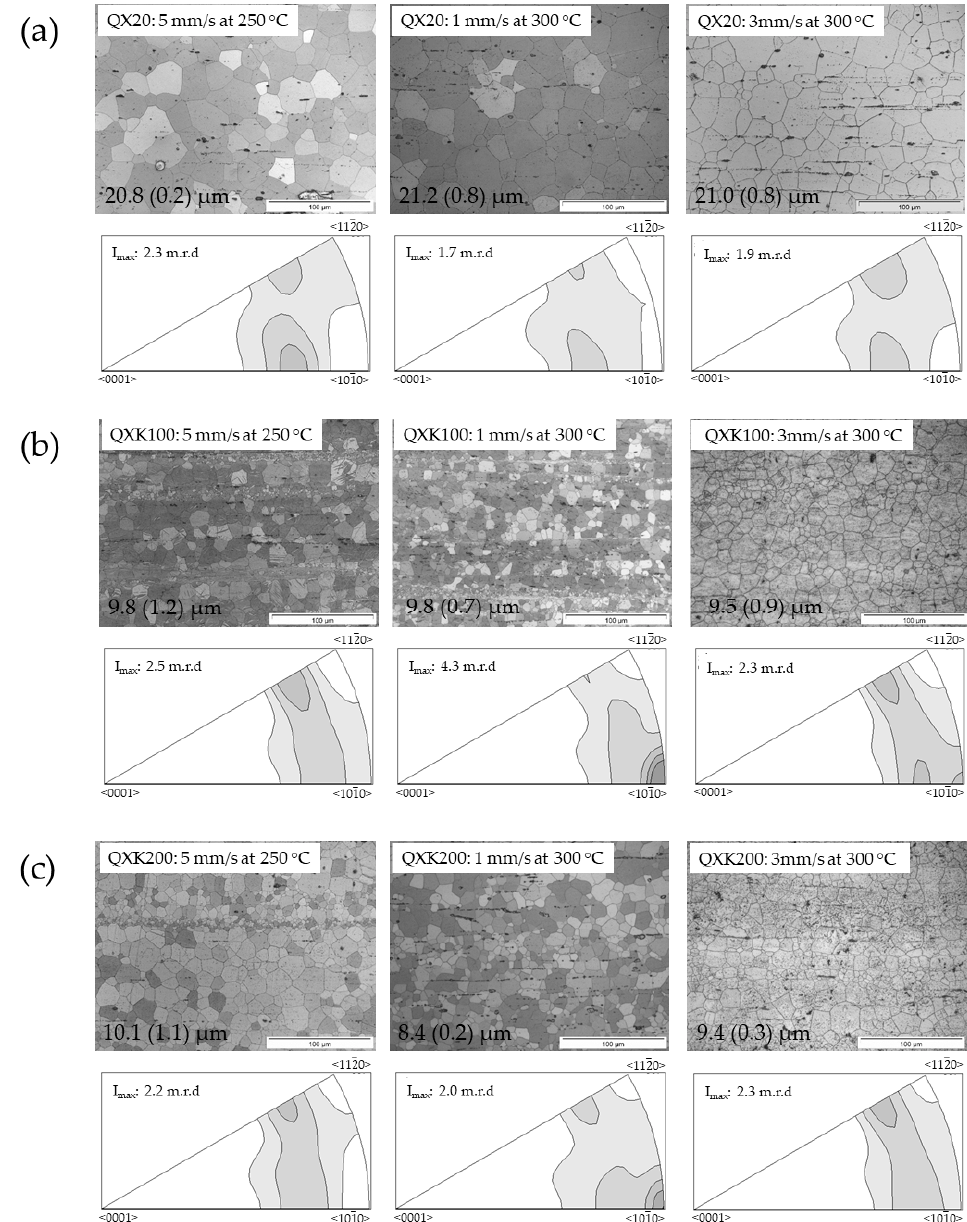
Figure 5. Micrographs from longitudinal sections and inverse pole figures in the extrusion direction of extruded Mg-Ag-Ca alloy (QX-series alloys) at varied temperatures and extrusion speeds; numbers indicate average grain sizes: ( a ) QX20; ( b ) QXK100; ( c ) QXK200.